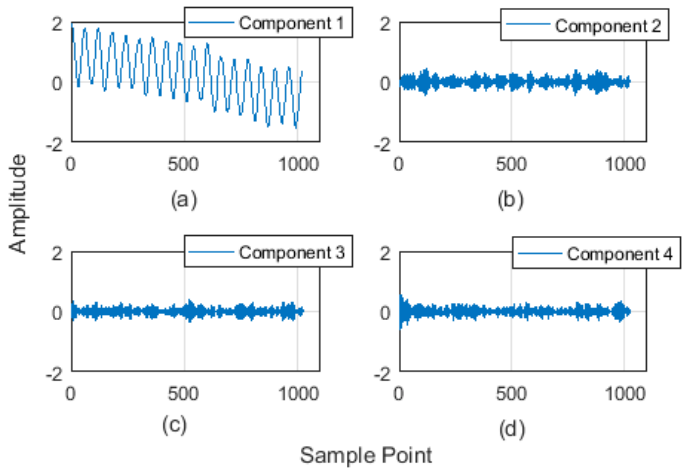
Figure 1. Decomposition results of 𝑍(𝑡): ( a ) component 1 of decomposition results; ( b ) component 2; ( c ) component 3; ( d ) component 4. Table 1. The correlation coefficients of each component in Figure 1.